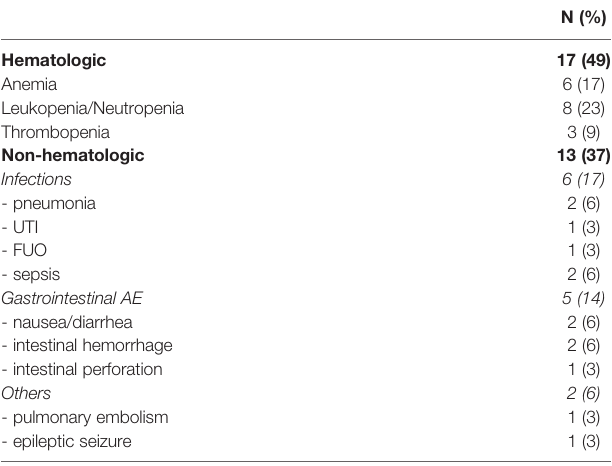
TABLE 3 | Adverse events ≥ CTCAE grade III occurring during the treatment of